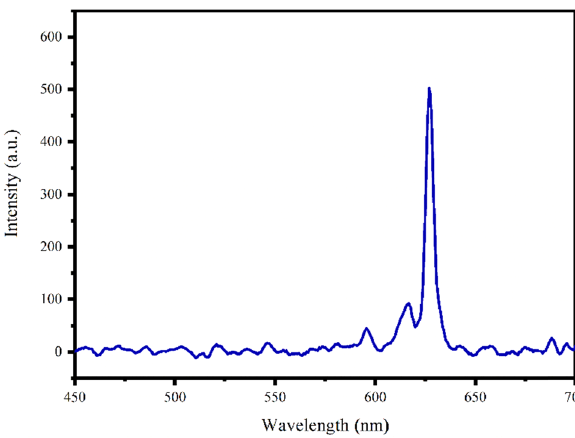
Figure 7: ( a and b ) Photographs of control sample ( without Gd 2 O 2 S:Eu@PEG ) and composite gel under daylight lamp. ( c and d ) Under 254 nm UV light.